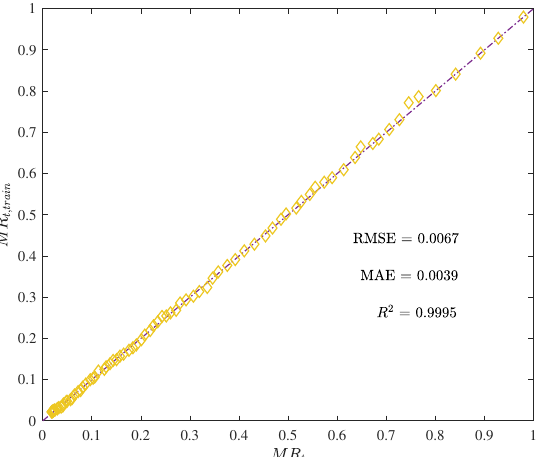
Figure 6. The moisture ratio given by the trained ANN model MR t , train vs. the actual moisture ratio MR t . Figures 7 and 8 display the training outcomes of the ELM. The attained RMSE, MAE, and R 2 values of 0.0040, 0.0027, and 0.9998, respectively, reveal a high degree of accuracy and exceptional efficacy in modeling the training data.